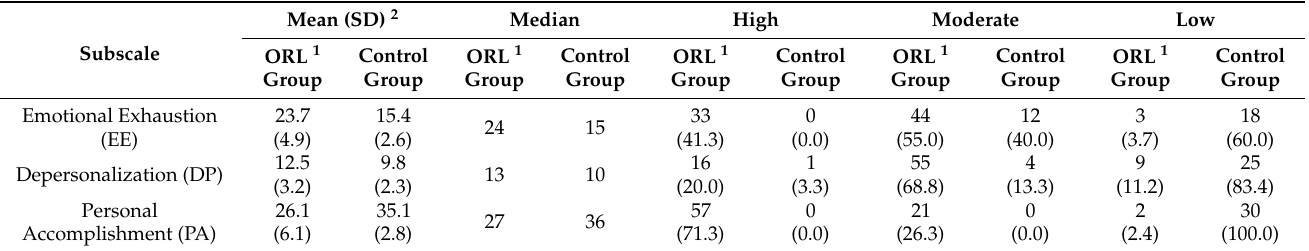
Table 3. Distribution of burnout subscales according to adjusted normative categories for both